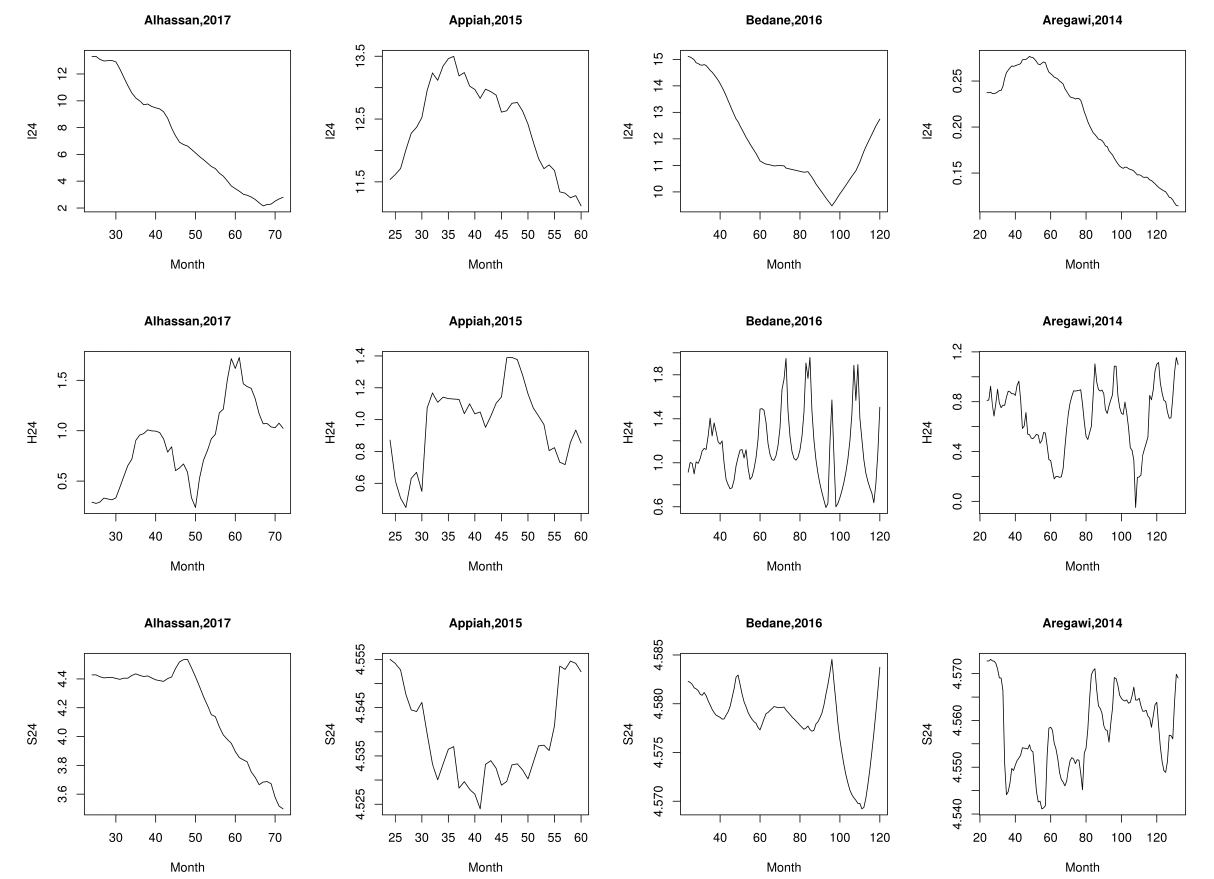
Figure A5. Comparative depiction of I 24 ( top ), H 24 ( middle ), S 24 ( bottom ) for (from left to right): Alhassan et al. (Kasena Nankana municipality in Ghana, 2017) [21], Appiah et al. (Ejisu-Juaben municipality in Ghana, 2015) [16], Bedane et al. (Kucha district in Ethiopia, 2016) [23], and Aregawi et al. (Ethiopia, 2014) [22].